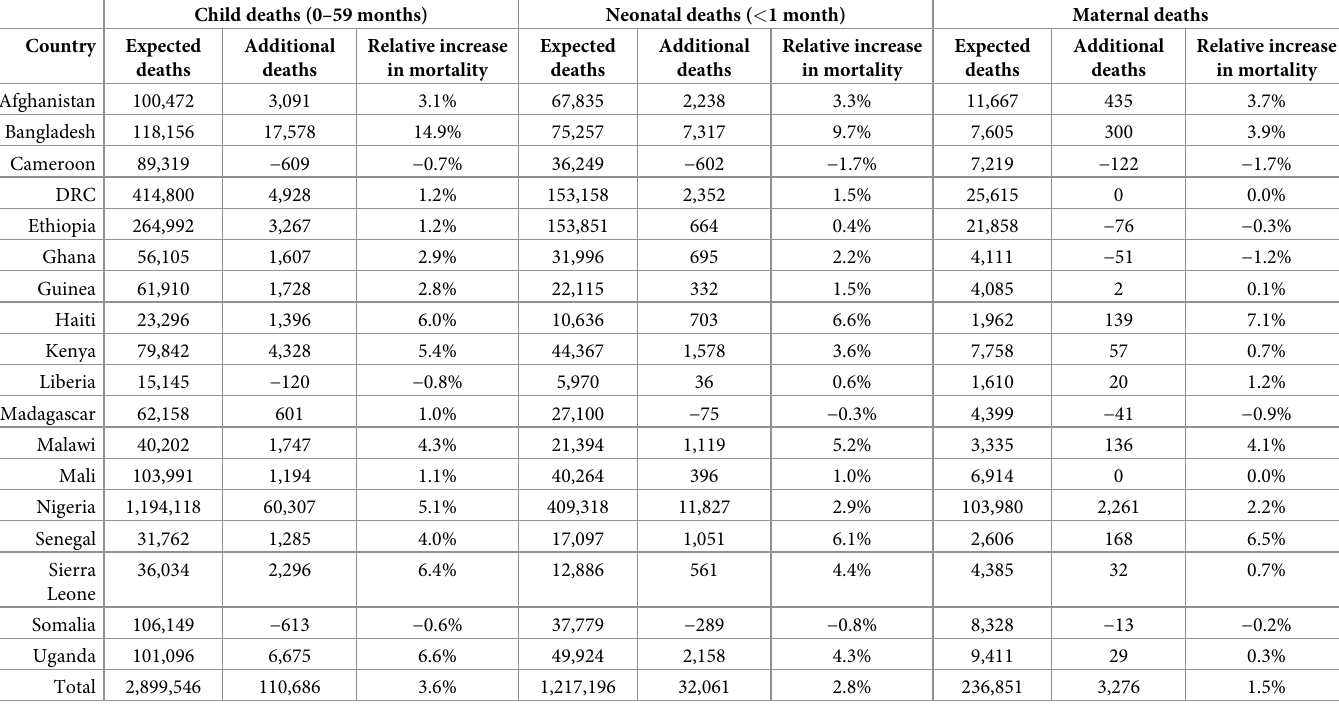
Table 4. Expected and additional child, neonatal, and maternal deaths, March 2020 to June